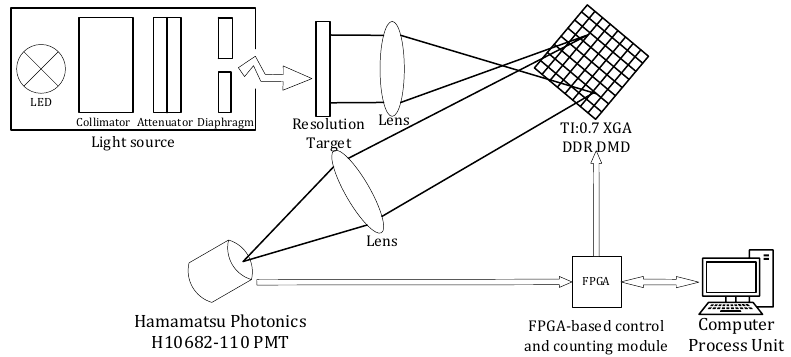
Figure 1. Schematic diagram of the single-photon compressed imaging system.